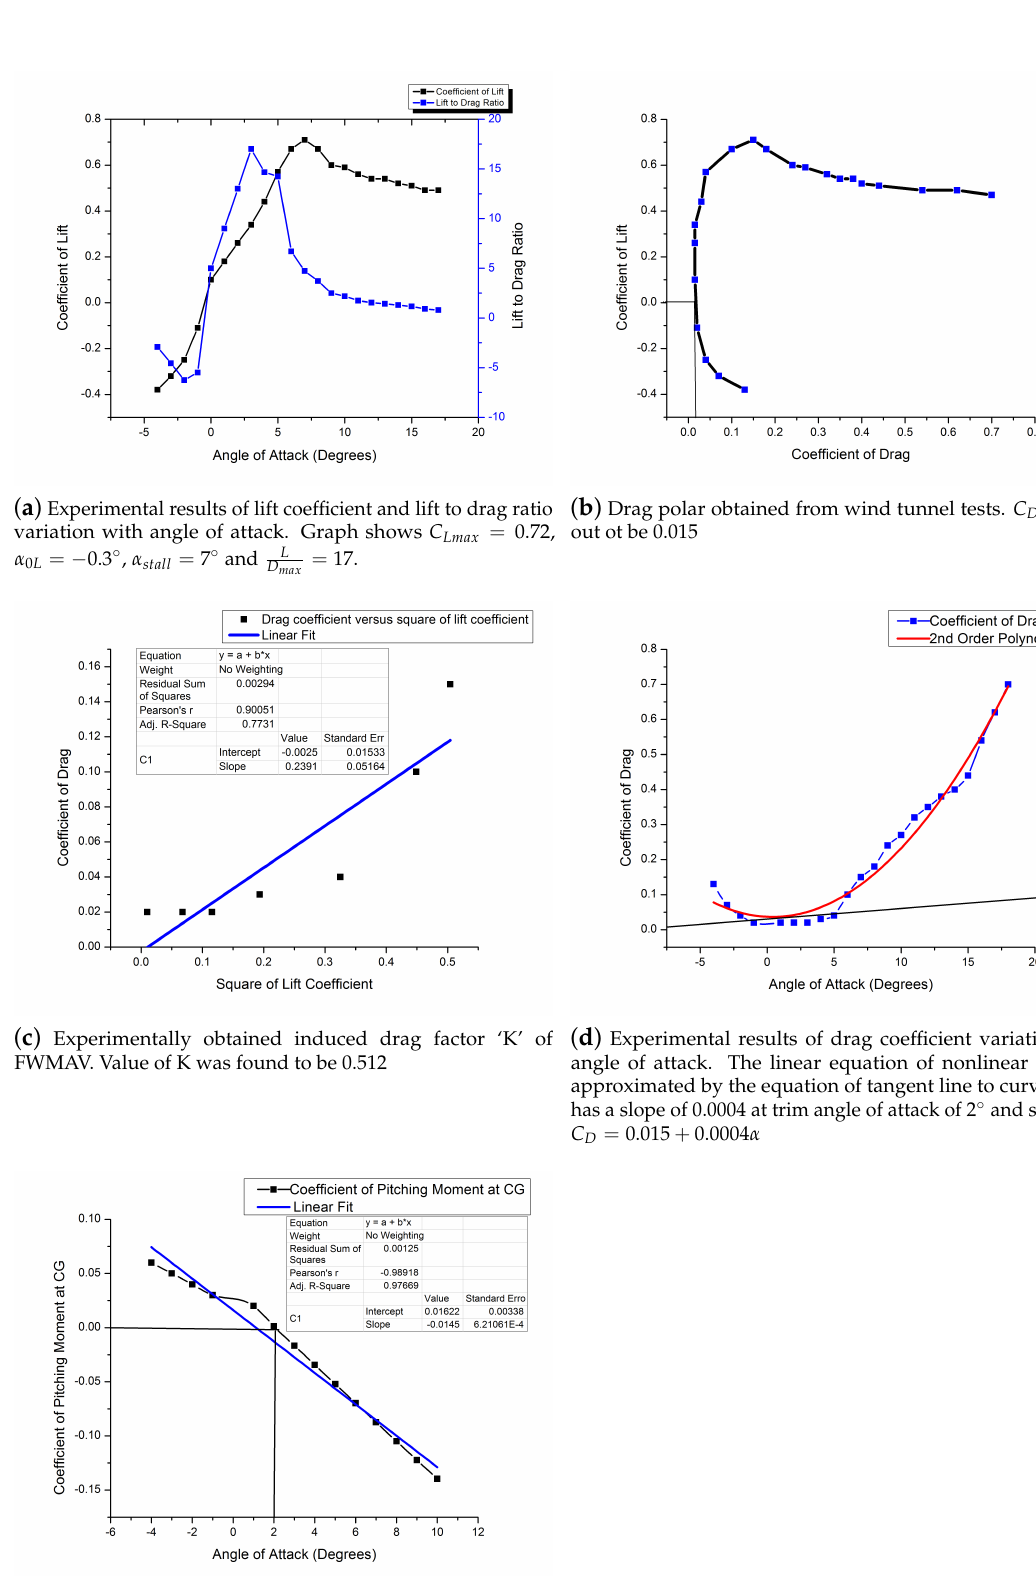
( e ) Experimental results of variation of pitching moment coefficient at CG with angle of attack.This graph shows C m 0 = Figure 6. Experimentally obtained wind tunnel